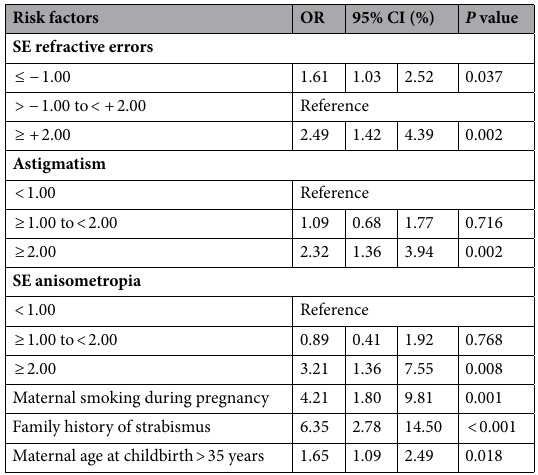
Table 5. Multivariate regression models for independent risk factors of strabismus in Hong Kong children. Adjusted for age, gender, refractive status and the associated factors (p < 0.1) from univariable analysis in a multivariate logistic regression model. Based on multivariate stepwise logistic regression model. SE spherical equivalent; CI confidence interval; OR odds